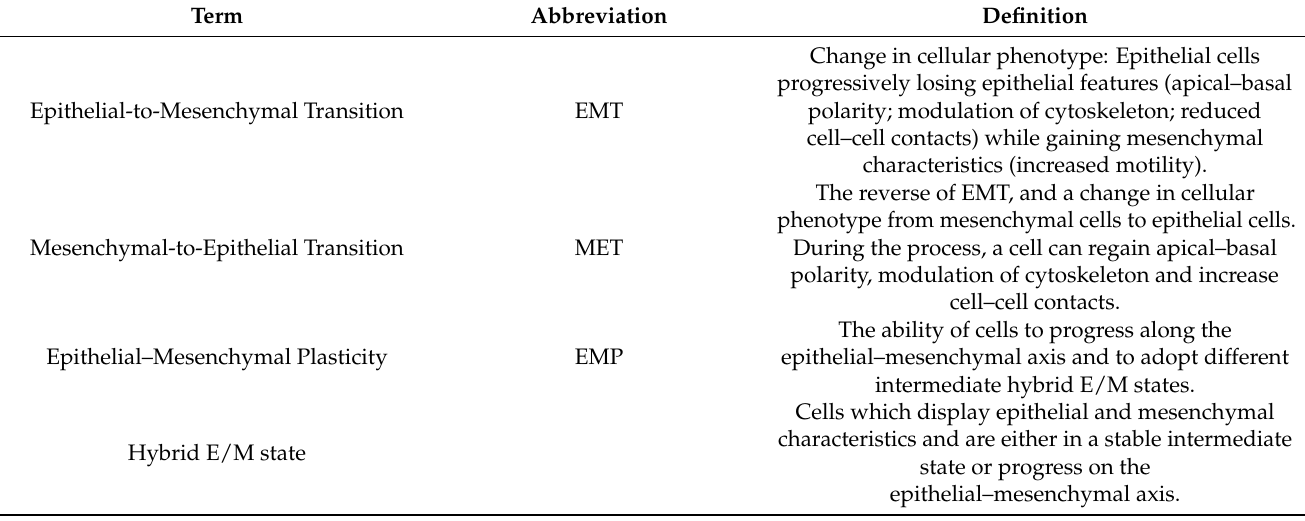
Table 1. Definition of EMT-associated terms